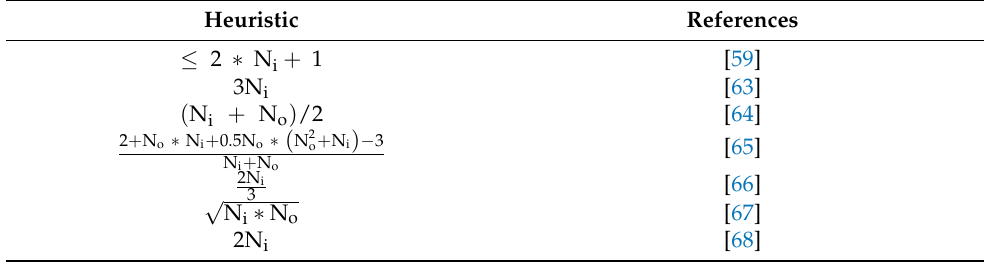
Table 10. The heuristics proposed for optimal number of